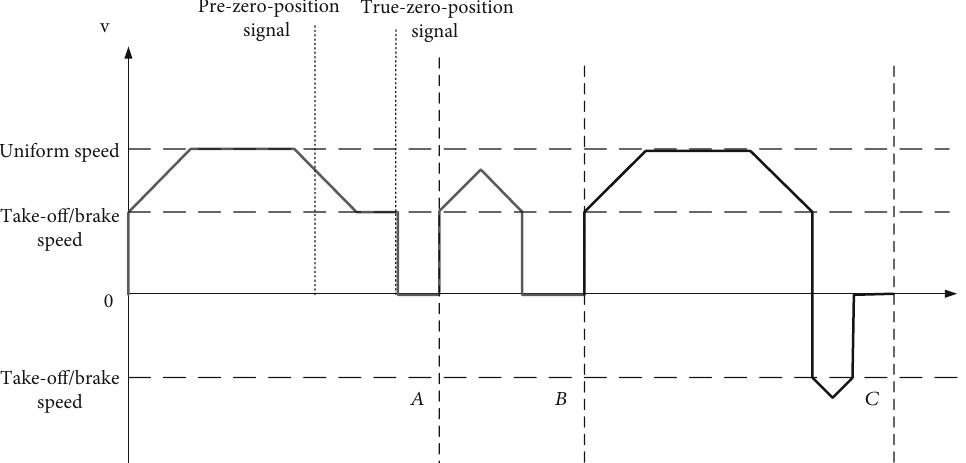
Figure 6: Possible speed